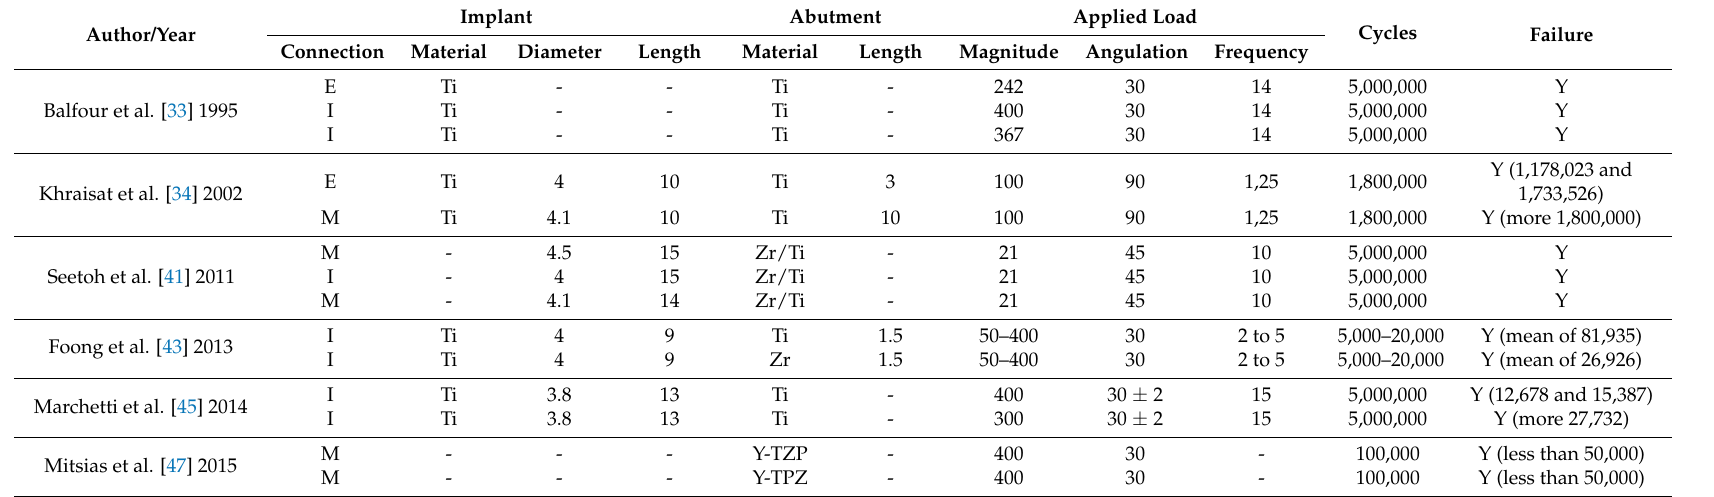
Table 4. Variables analyzed from the answer to question